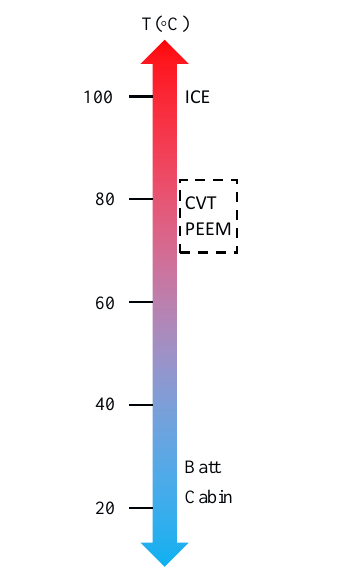
Figure A4. Operating temperature levels of electrified powertrain